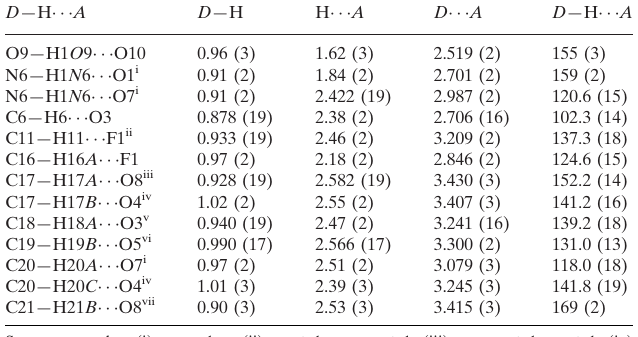
Hydrogen-bond geometry (A˚ , (cid:4) ). D —H (cid:2)(cid:2)(cid:2)